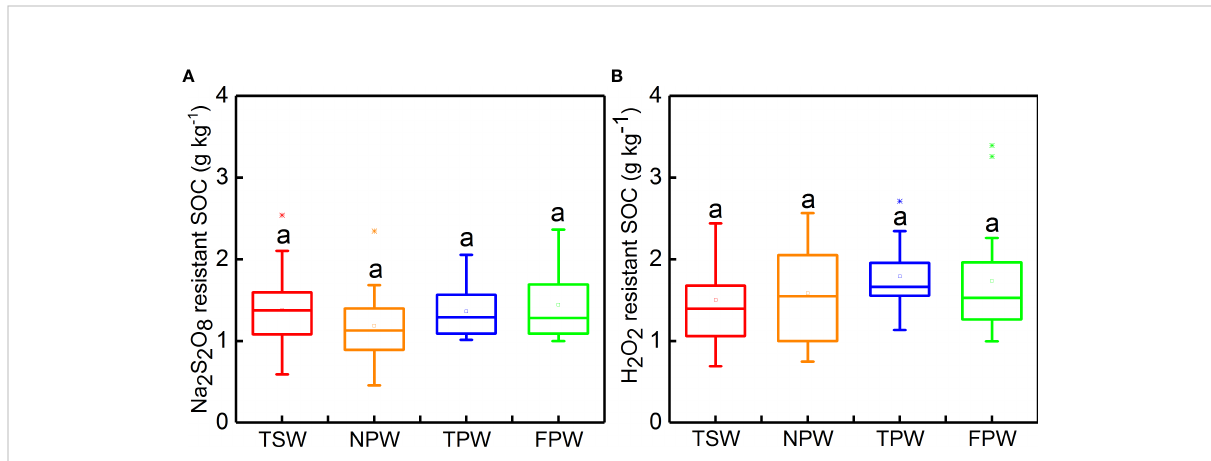
FIGURE 2 Box chart of Na 2 S 2 O 8 resistant SOC (A) and H 2 O 2 resistant SOC (B) in 0-25 cm soils in the four wetlands. (Different lowercase letters represent signi fi cant differences at p < 0.05